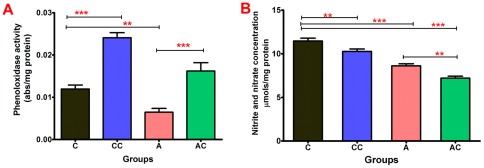
Phenoloxidase activity (A) and nitrite and nitrate production (B) in Rhodnius prolixus 5th-instar nymphs challenged by Trypanosoma cruzi Dm28c clone. Anterior midgut samples collected nine days after feeding and infection.Treatments: C – control insects fed on blood alone; CC – parasite infected insects; A – insects treated antibiotic; AC- insects treated with antibiotic and infected with the parasite. Bars represent mean ± SEM. Means were analyzed by using 1 way ANOVA comparing all groups to the control (C) and all groups to the insects treated with antibiotic (A). Each experiment represents the mean (+/−SEM) of four separate experiment, n = 6–10 insects for each determination; p<0.001, *** extremely significant, ** very significant and * significant.